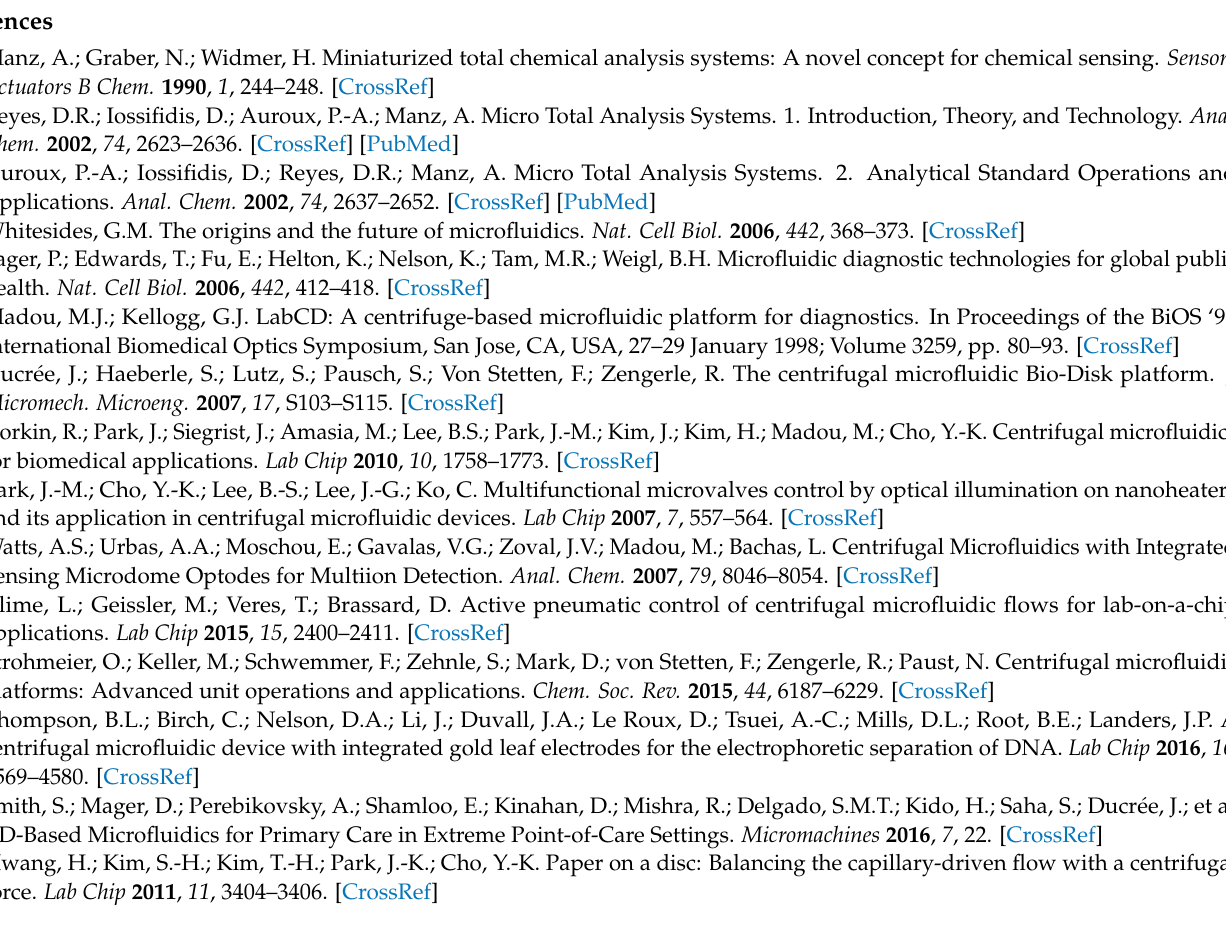
performance indicators. Table A1 gives of overview or generic values which can be used to initiate the optimization. Table A1. Default geometrical parameters and relationships of CP-DF siphon valves (Figure 1). The resulting critical spin rate Ω ( R , Γ , U 0 ) /2 π ≈ 22 Hz. Minimum lateral dimensions are given by the smallest practical diameter of milling tools (200 µ m). As tools for injection molding are often adopted from optical data storage (e.g., CD, DVD, Blu-ray), a central, 1.5 cm diameter hole and a disc radius of 6 cm with thickness around 1.2 mm, fluidic structures Γ may need to stay within the radial interval between R min = 1.5 cm and R max = 5.5 cm, and an upper limit for the depth of about 1 mm. The lowest depth of cavities is often restricted by the sealing technology; for large lateral extensions or small aspect ratios, sagging of the lid, which is often a foil, may significantly change the nominal volume capacity, also in response to the pressure, and might even lead to sticking to the bottom of the cavity. R = 3 cm R min = 1.5 cm R max = 5.5 cm R DF = 3.15 cm > R A 0 = d 0 · w 0 d 0 = 1 mm w 0 = 5 mm U 0 = 100 µ L < A 0 · ( R − R min ) U iso = d 0 · h · L (cid:28) U 0 d iso = 1 mm h iso = 1 mm L iso = 15 mm > w 0 + w U Z = d · w · Z d = 500 µ m w = 800 µ m (cid:28) w 0 Z = 10